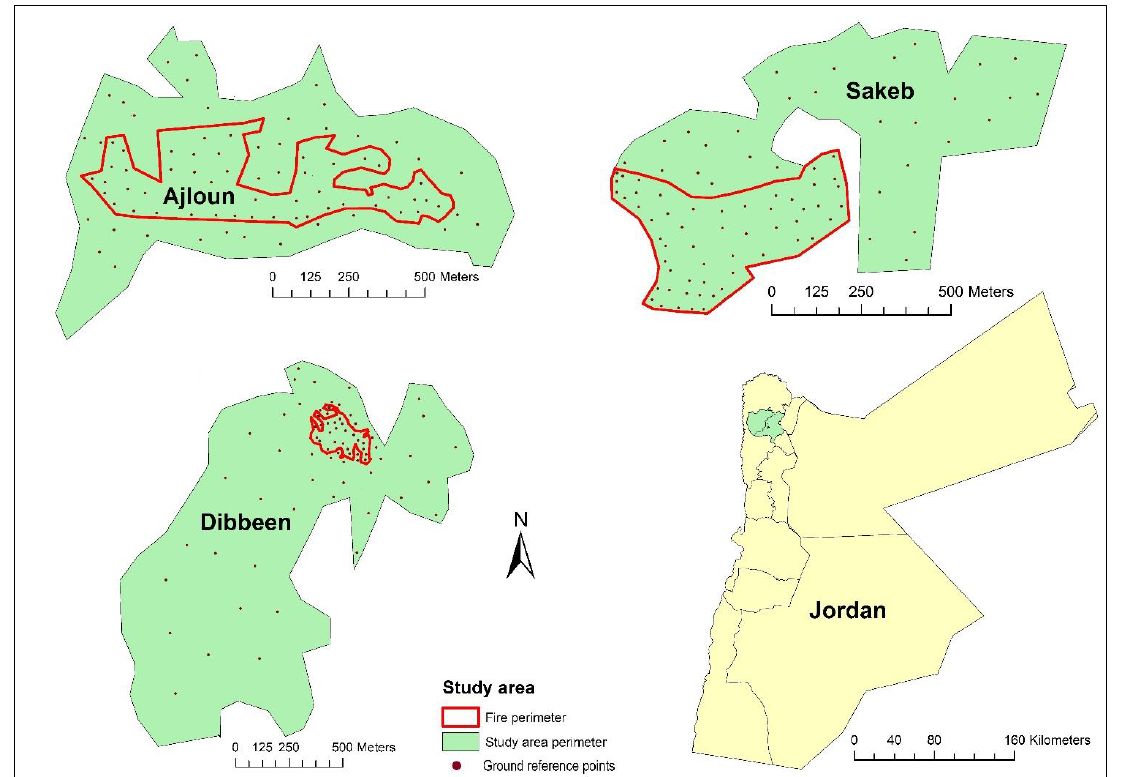
Figure 1. Location of the Ajloun, Dibbeen and Sakeb forest fire sites, Northern Jordan.